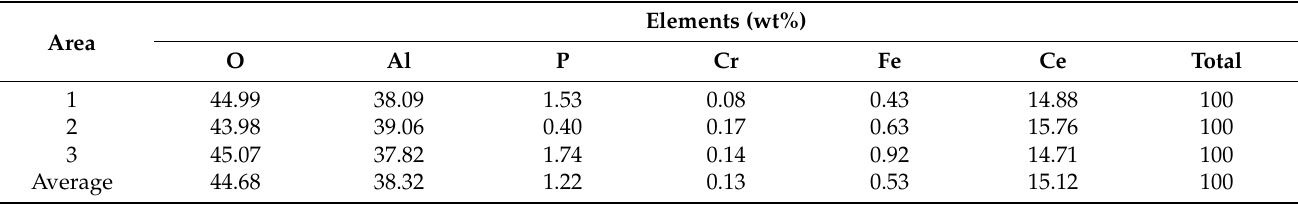
Table 3. Integral elemental composition over the surface of the Fe-Cr-Al foil sample after heating at 900 ◦ C and phosphating at 400 ◦ C with a deposited secondary carrier.